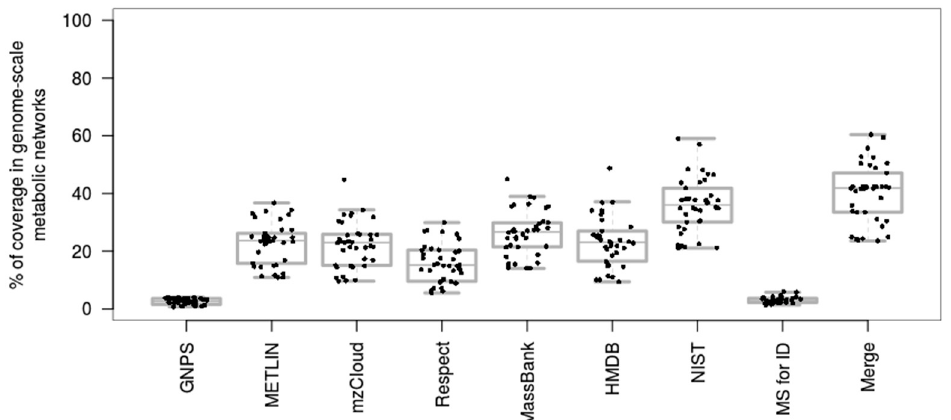
Figure 3. Coverage of prokaryotic and eukaryotic metabolic networks by individual mass spectral databases. HMDB and NIST include MS 2 and electron ionization (EI)-MS spectral information. Box plots show the distribution of the percentages of coverage in 38 different genome-scale metabolic networks.